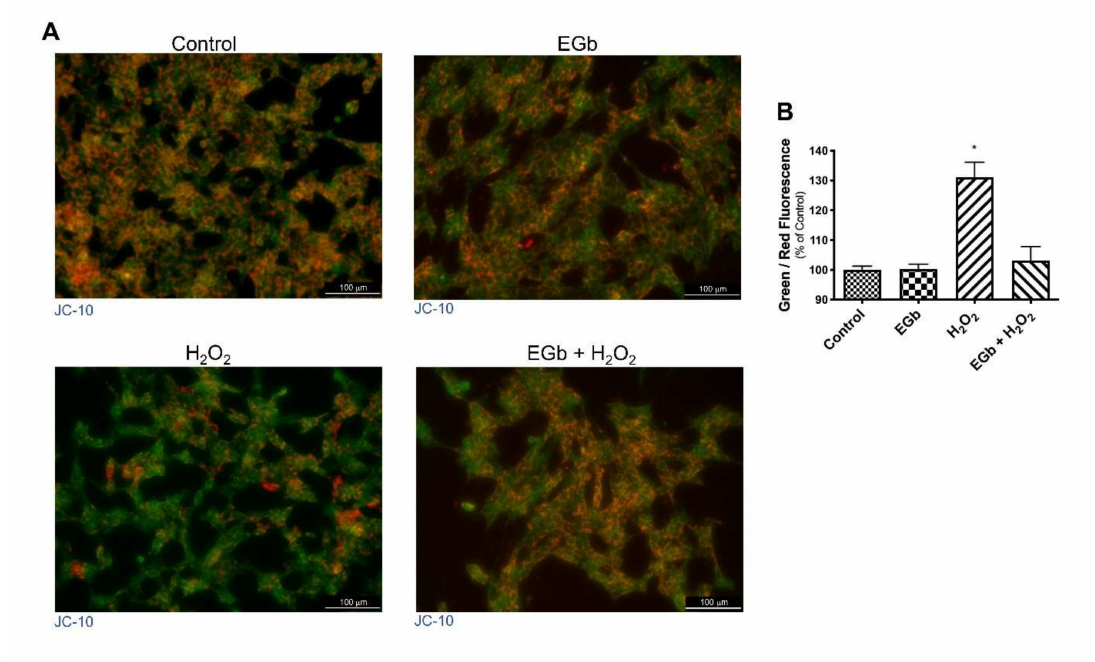
Figure 4. EGb reduce the decrease of mitochondrial membrane potential. Fluorescence analysis of mitochondria in control or EGb treated cells with or without H 2 O 2 ( A ). Histogram reports quantification of fluorescence of Red (540 / 570 nm) and green (485 / 534 nm) ( B ). The bars represent ± the average ± SD of independent experiments ( n = 3). Statistically significant di ff erence compared to control cells: * p ≤ 0.05). Cells treated with DMSO were used as